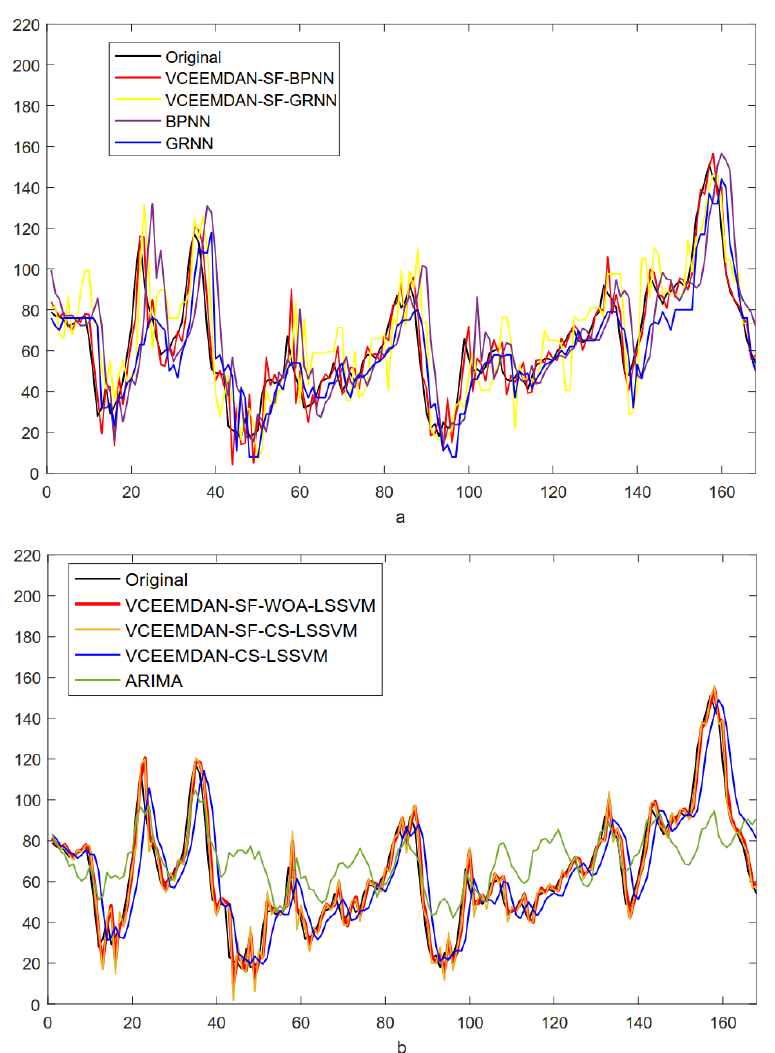
Figure 9. The forecast results in Beijing: ( a ) demonstrate the SF effects on general regression neural network (GRNN) and BP neural networks (BPNN) models and ( b ) illustrate the superiorities of SF and WOA in the proposed combined